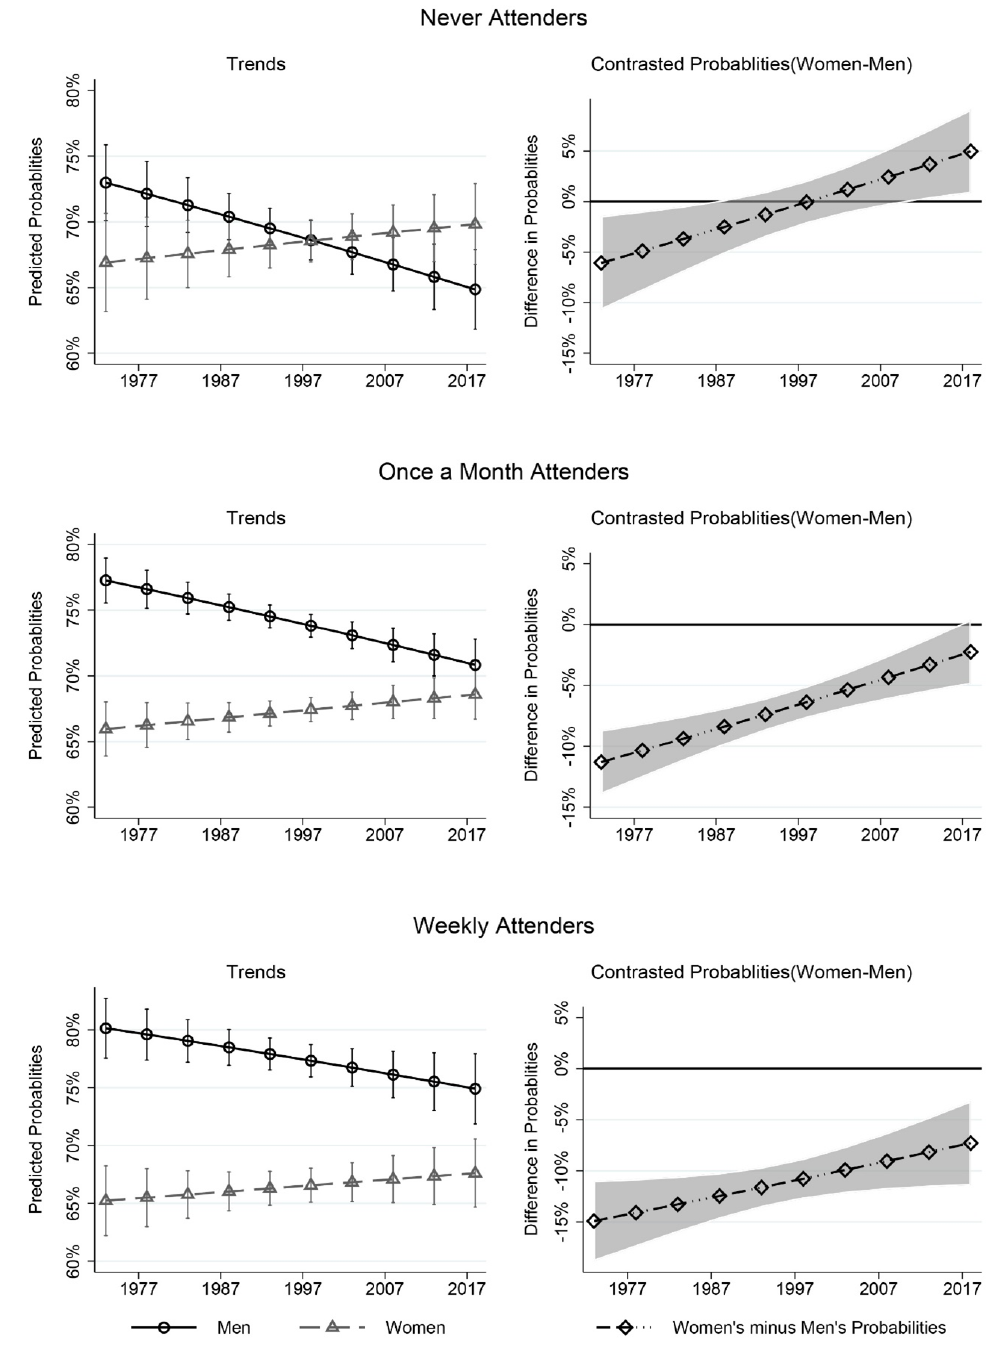
Figure 2: Trends in gender differences in desire to work across levels of religious service attendance with rela- tive difference plots. Source: General Social Survey, 1977 to 2018. Models underlying predicted probabilities parallel those in Table 1. They include the following controls: religious affiliation, happiness, full-time work status, job satisfaction, equivalized family income, marital status, number of children, education, age, race, whether born in the United States, region, and whether respondent lives in a